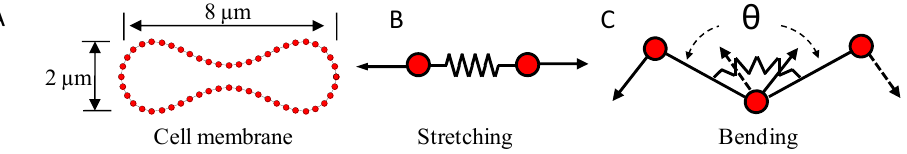
Figure 1. ( A ) Spring connected network cell membrane model. Kinematics for local stretching ( B ) and bending ( C ) modes of response.